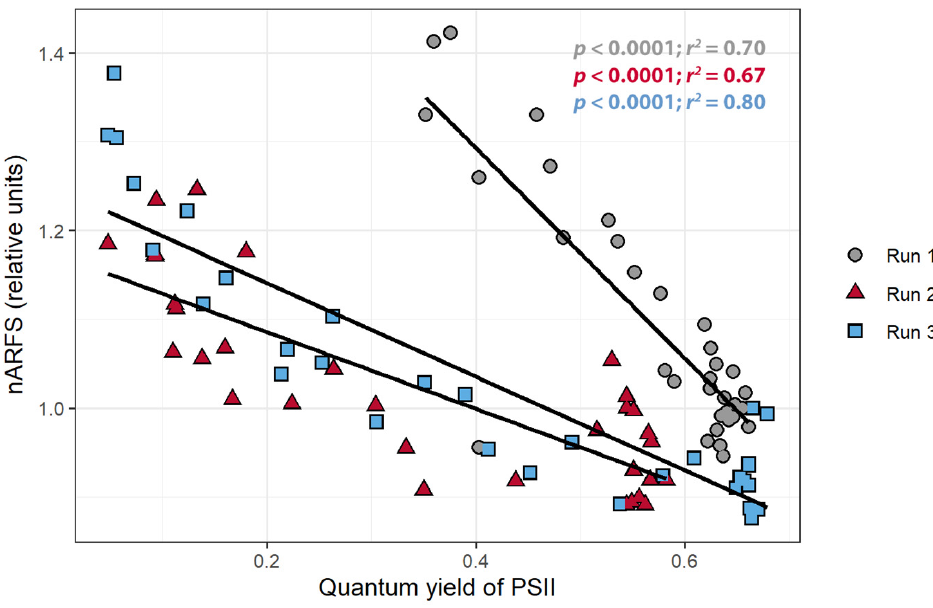
Figure 7. The relationship between the normalized average reflectance of fluorescence spectrum (nARFS) and the quantum yield of photosystem II of Catharanthus roseus treated with atrazine.